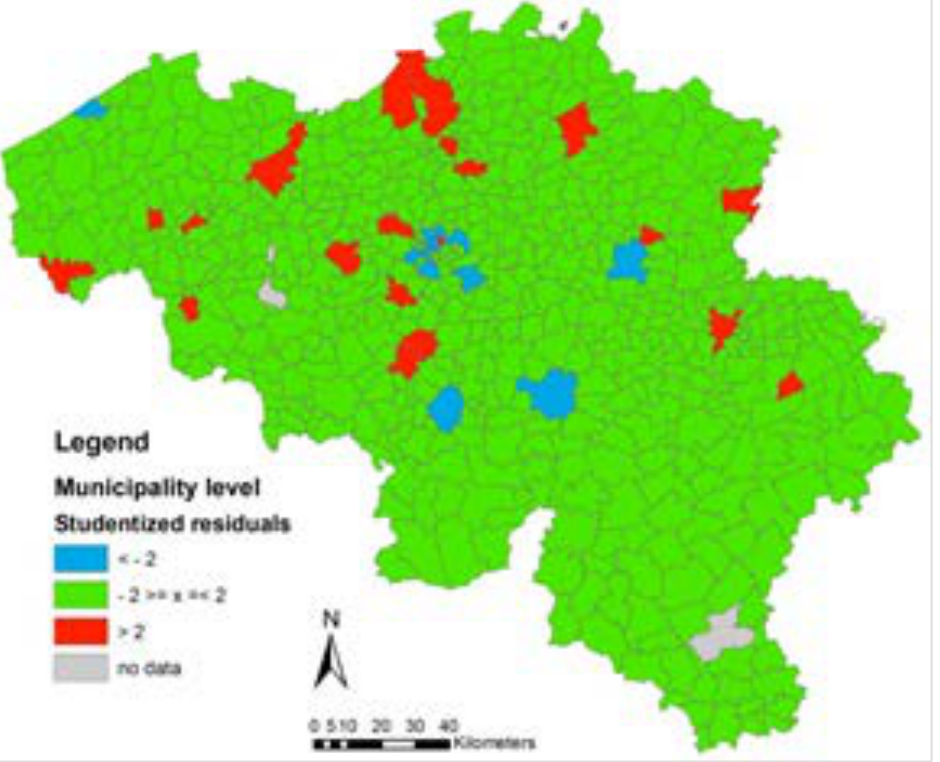
Figure 3. Studentized residual for OLS regression analysis for agricultural products and live animals on municipality